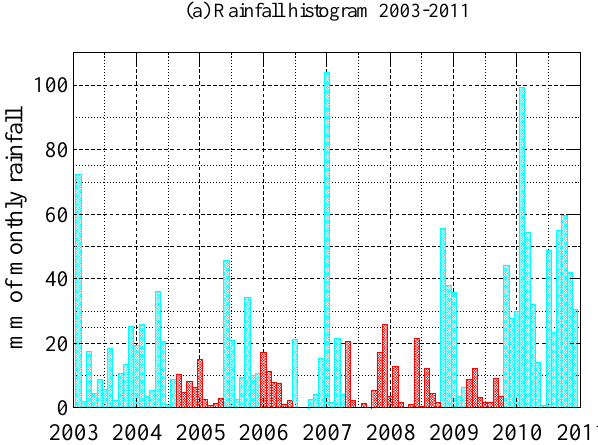
Fig. 6. Spatial components of PCA 1st orthogonal Fig. 5. Time series of TWS means over the estimated desert region (Central Australia) of 18 tiles, the largest signal amplitudes are lesser than 30 mm and the RMS value is of 19 mm.